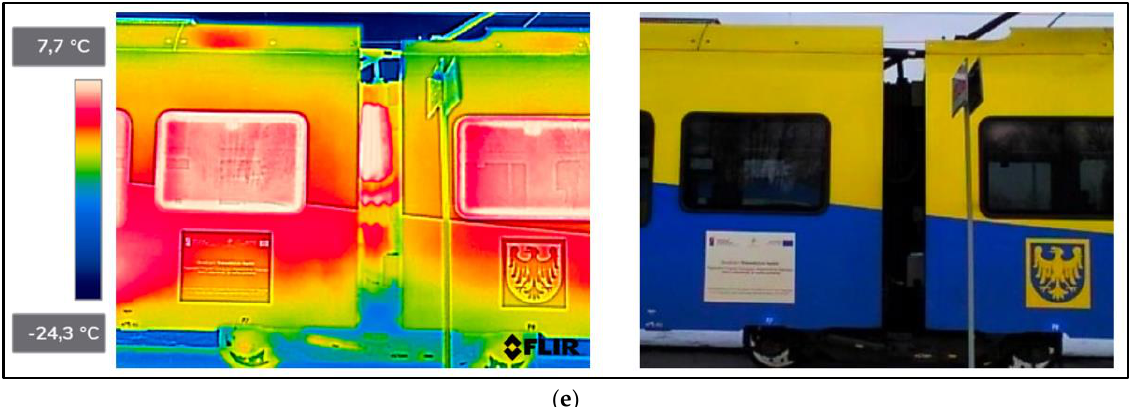
Figure 7. EN75-004 − thermogram of critical components of the railway vehicle: ( a ) door − upper part from inside the vehicle; ( b ) door − lower part from inside the vehicle; ( c ) door from outside the vehicle; ( d ) interconnection from inside the vehicle; ( e ) interconnection from outside the vehicle.